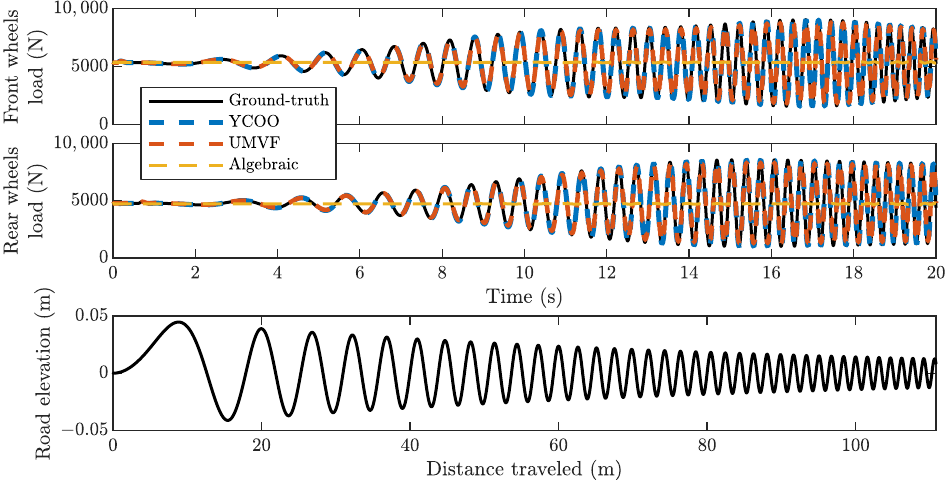
Figure 6. Vertical tire force estimation during a bounce sine sweep test. Vehicle speed is constant at 20kmh − 1 . The minimum wavelength is 1.6m at t = 20%. The bottom figure shows the road profile.